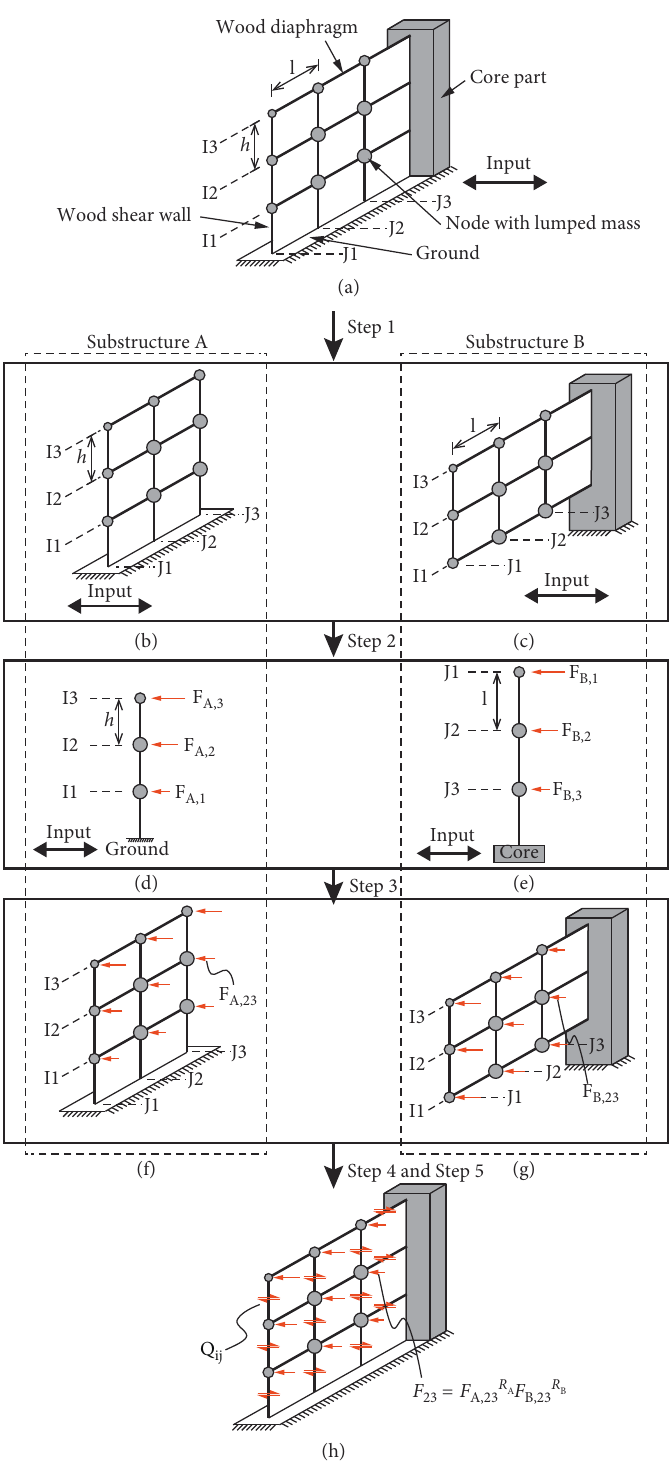
Figure 3: Flowchart of the DELF